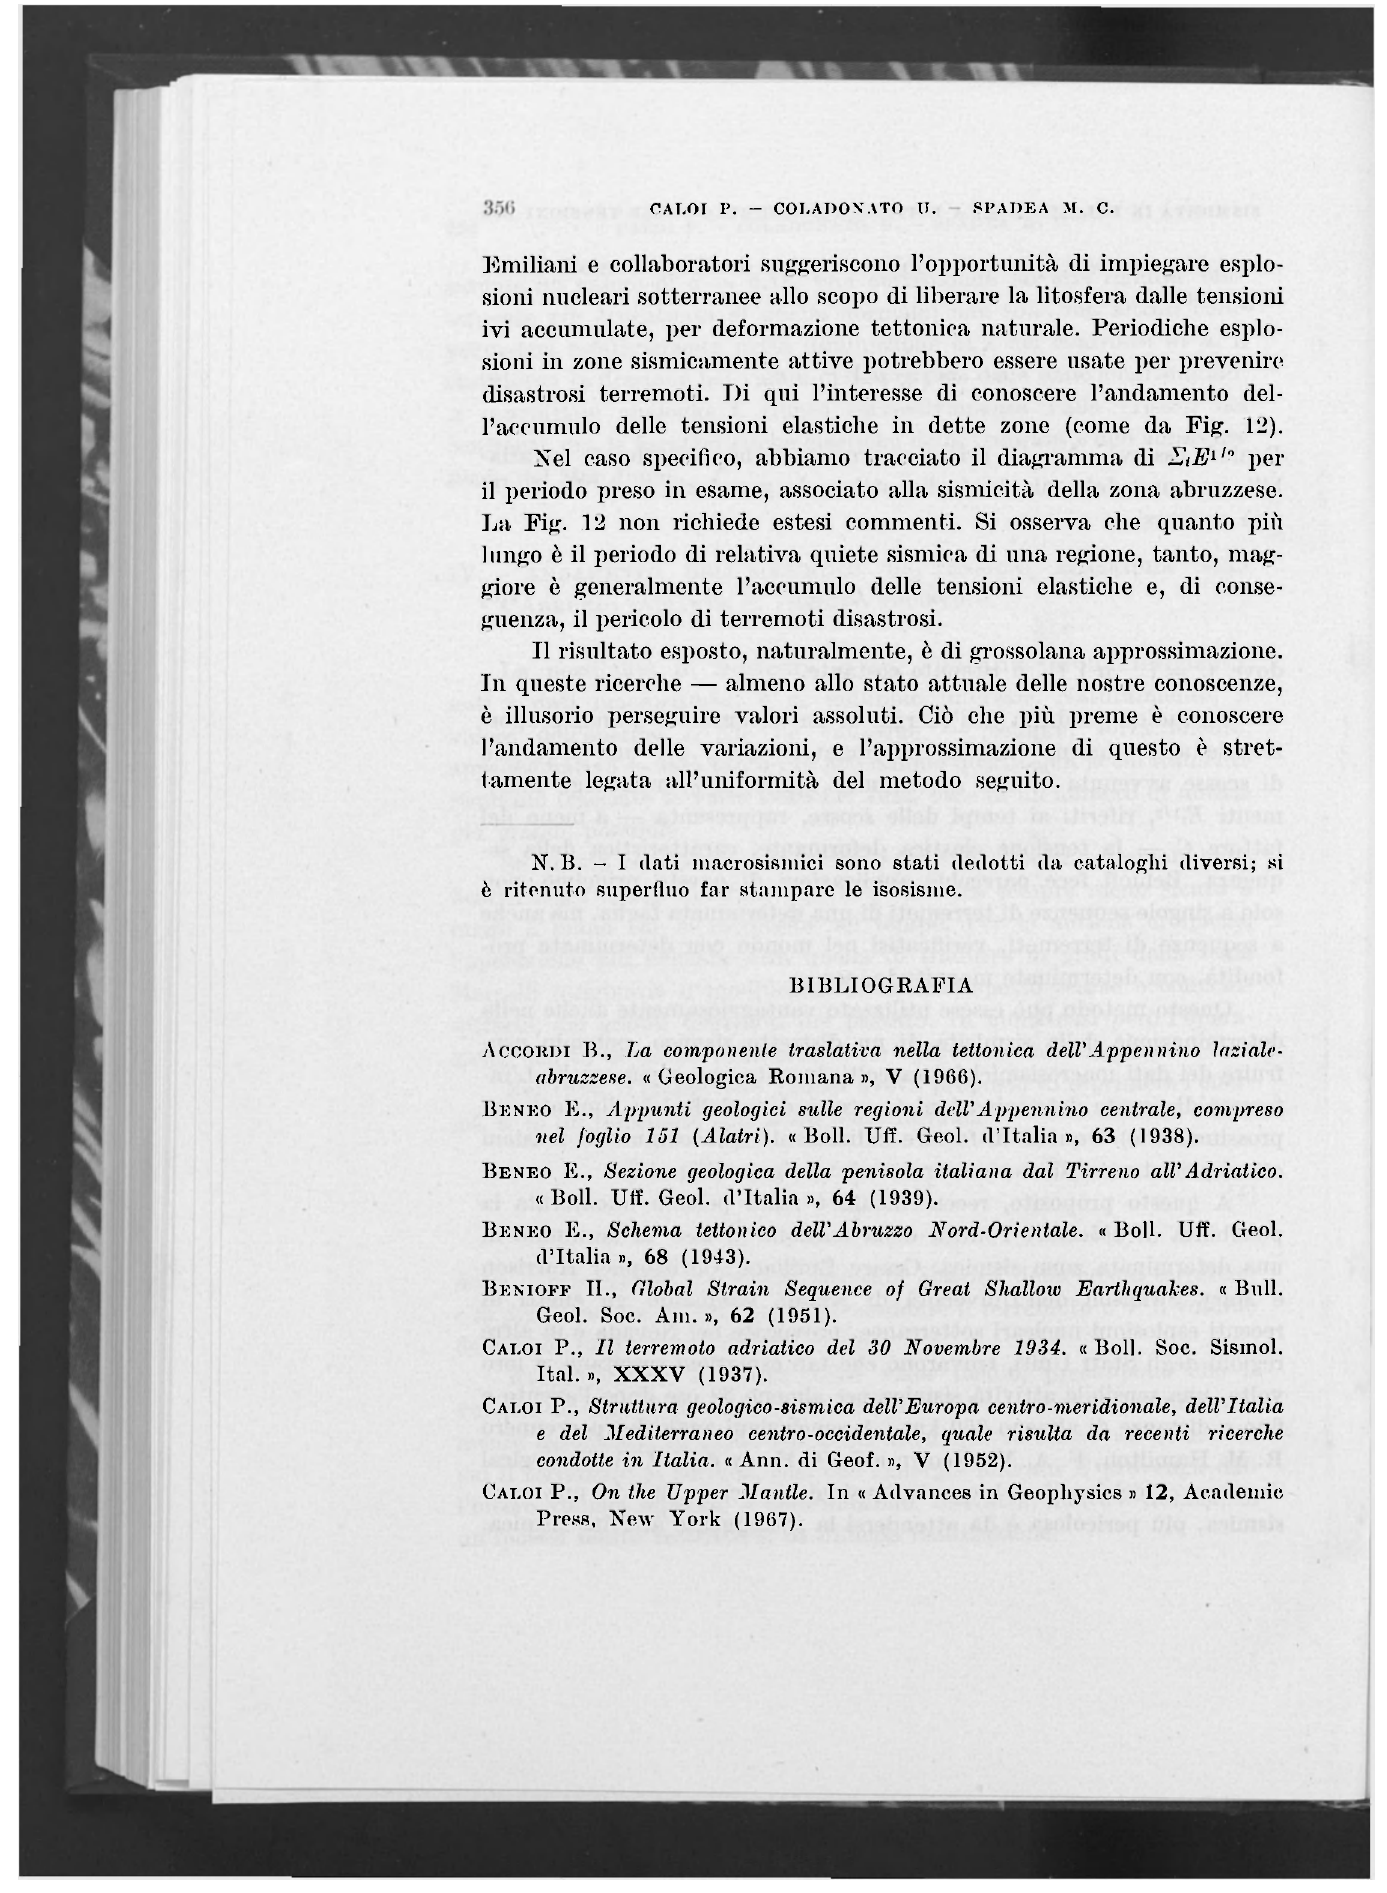
N. B. - I dati macrosismici sono stati dedotti da cataloghi diversi; si è ritenuto superfluo far stampare le